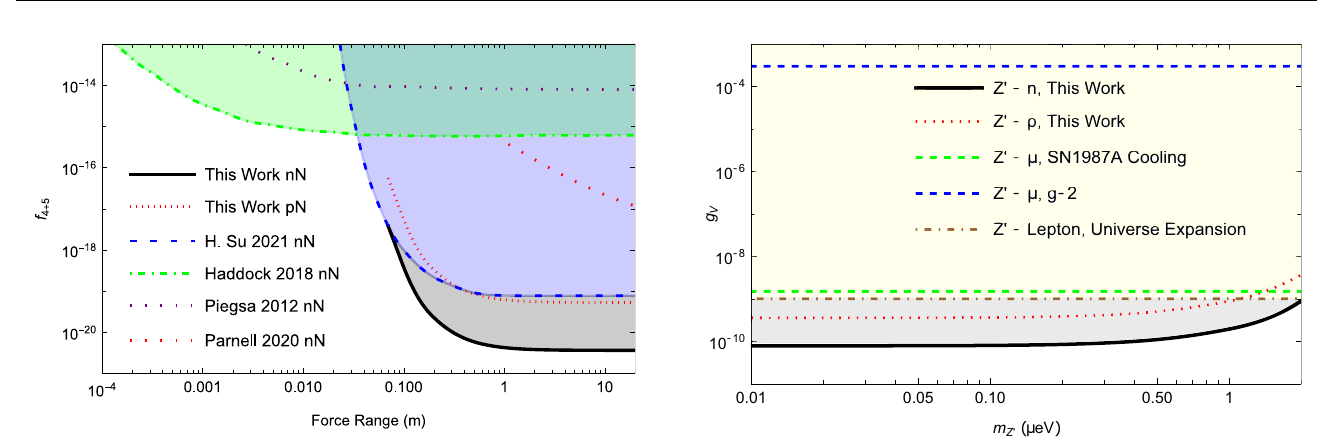
Fig. 3 | Experimentalresults ofthe b Ne y . Each point represents anaverage ofa 4-h dataset, (cid:1) b Ne y . The error bars represent the statistical and systematic error of the comagnetometer combined in quadrature. Histogram of (cid:1) b Ne y is shown in the inset,